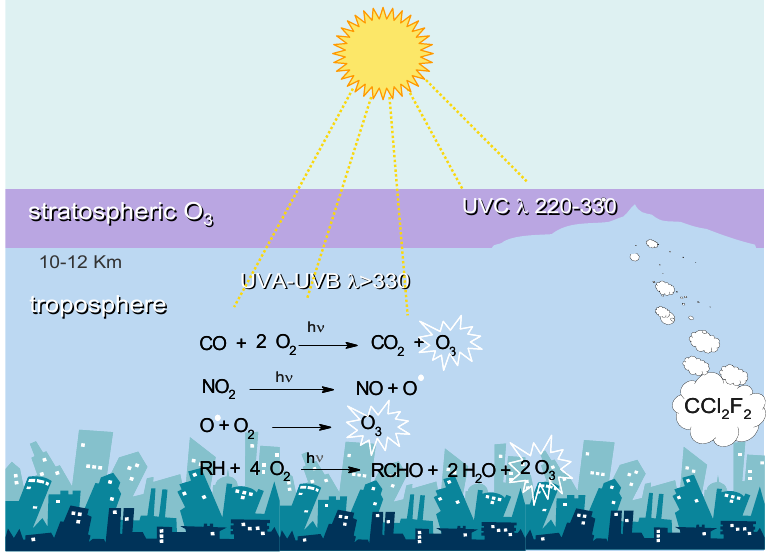
Figure 3. Beneficial and detrimental pools of ozone in the stratosphere and troposphere, respectively. In the stratosphere this pool is depleted by fluorochlorocarbons (CCl while in the troposphere it is raised by photochemical